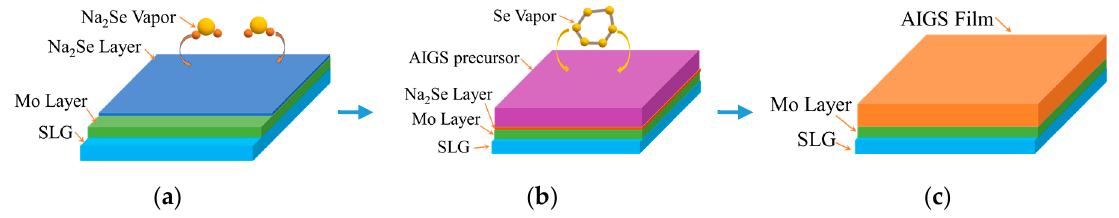
Figure 2. Schematic of the AIGS film fabrication process: ( a ) Na 2 Se fabrication process; ( b ) AIGS precursor annealing process; and ( c ) schematic of the AIGS film.